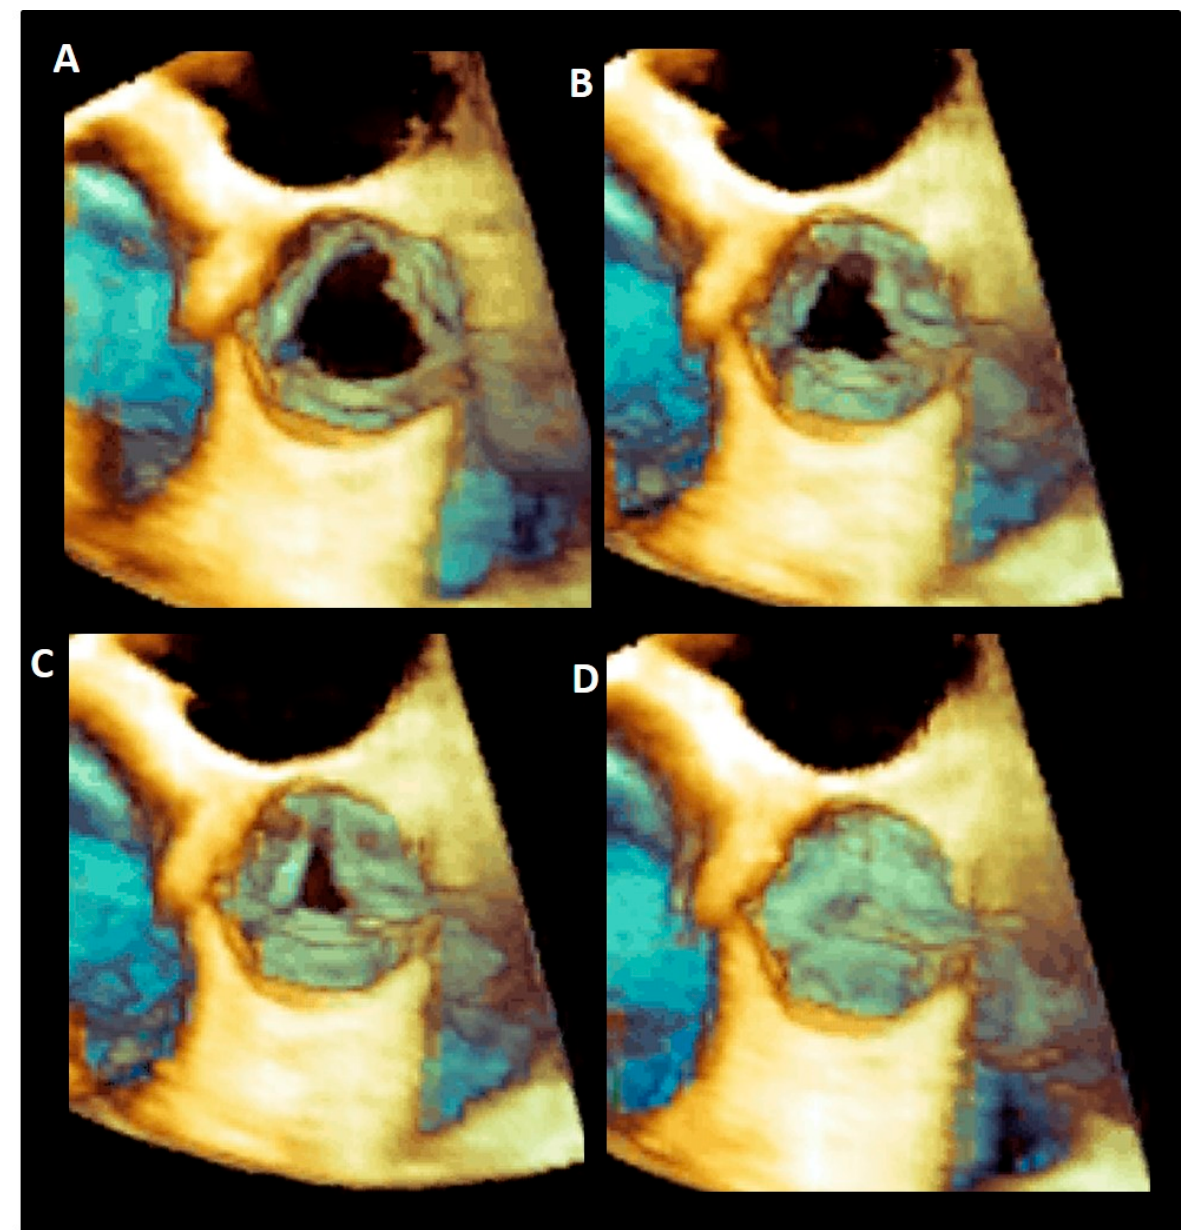
Figure 8. ( A – D ) Tridimensional 3D TEE showing the progressive closure of aortic leaflets during the systole.